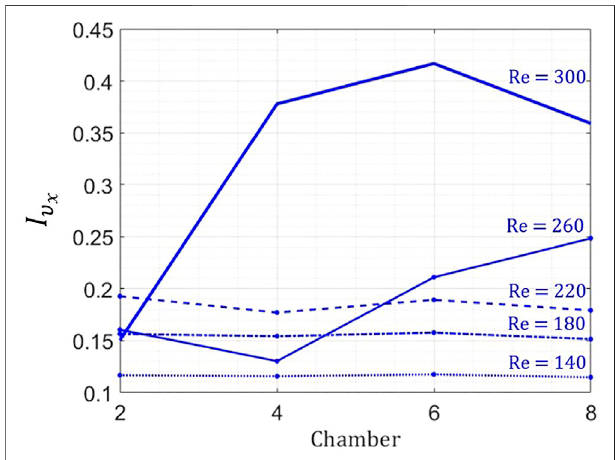
FIGURE 6 | Turbulence intensity on the centre of ExtendedNUB chambers C2, C4, C6 and C8 for D/d (cid:1) 6.65 at Re (cid:1) 140, 180, 220 and 260 and 300, from 17 to 34 s fl